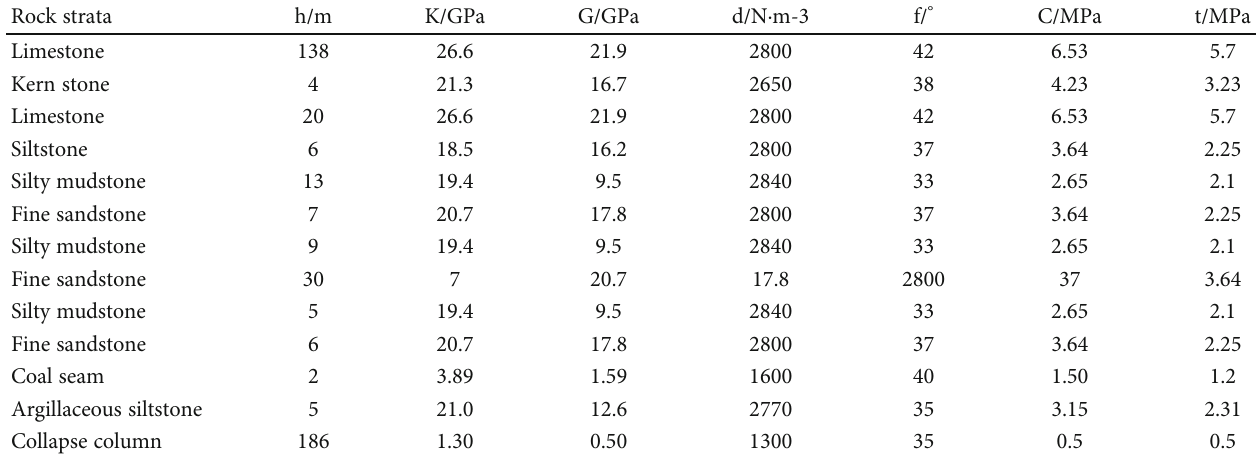
Table 1: The physical parameters of rock mass.